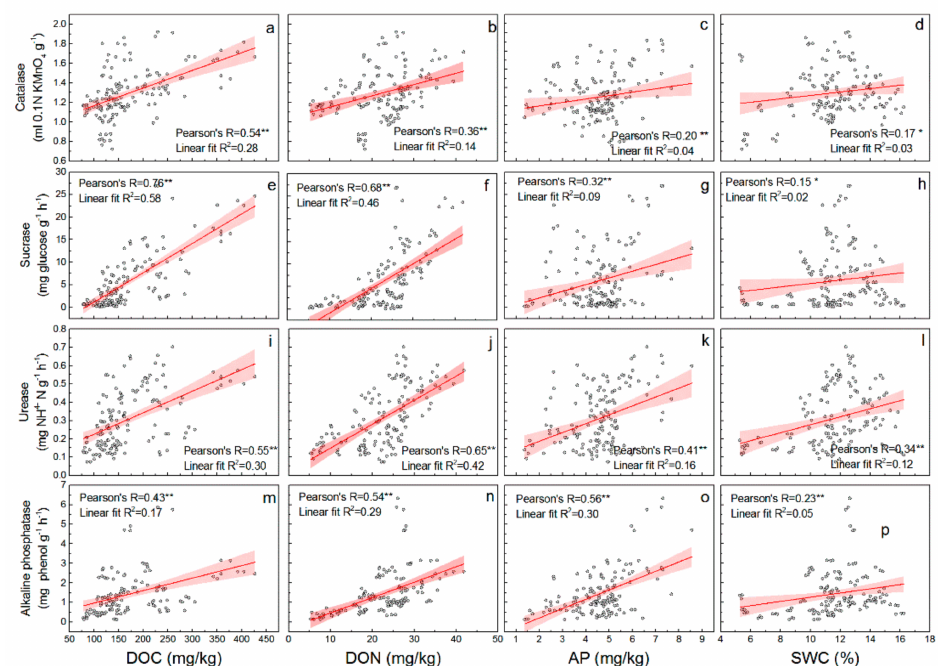
Figure 4. Linear fitting and Pearson’s correlation coe ffi cients (Pearson’s R) between soil properties and soil enzyme activities across all treatments. For each subfigure, n (144) = four seasons × four land-use types × three soil depths × three replications. The line is the linear fitting line, and the shaded bands delineate the 95% confidence interval of the regressions. ** and * correspond to the statistically significant levels of p < 0.01 and p < 0.05, respectively. DOC, DON, AP, and SWC represent dissolved organic carbon, dissolved organic nitrogen, available phosphorus, and soil water content, respectively.